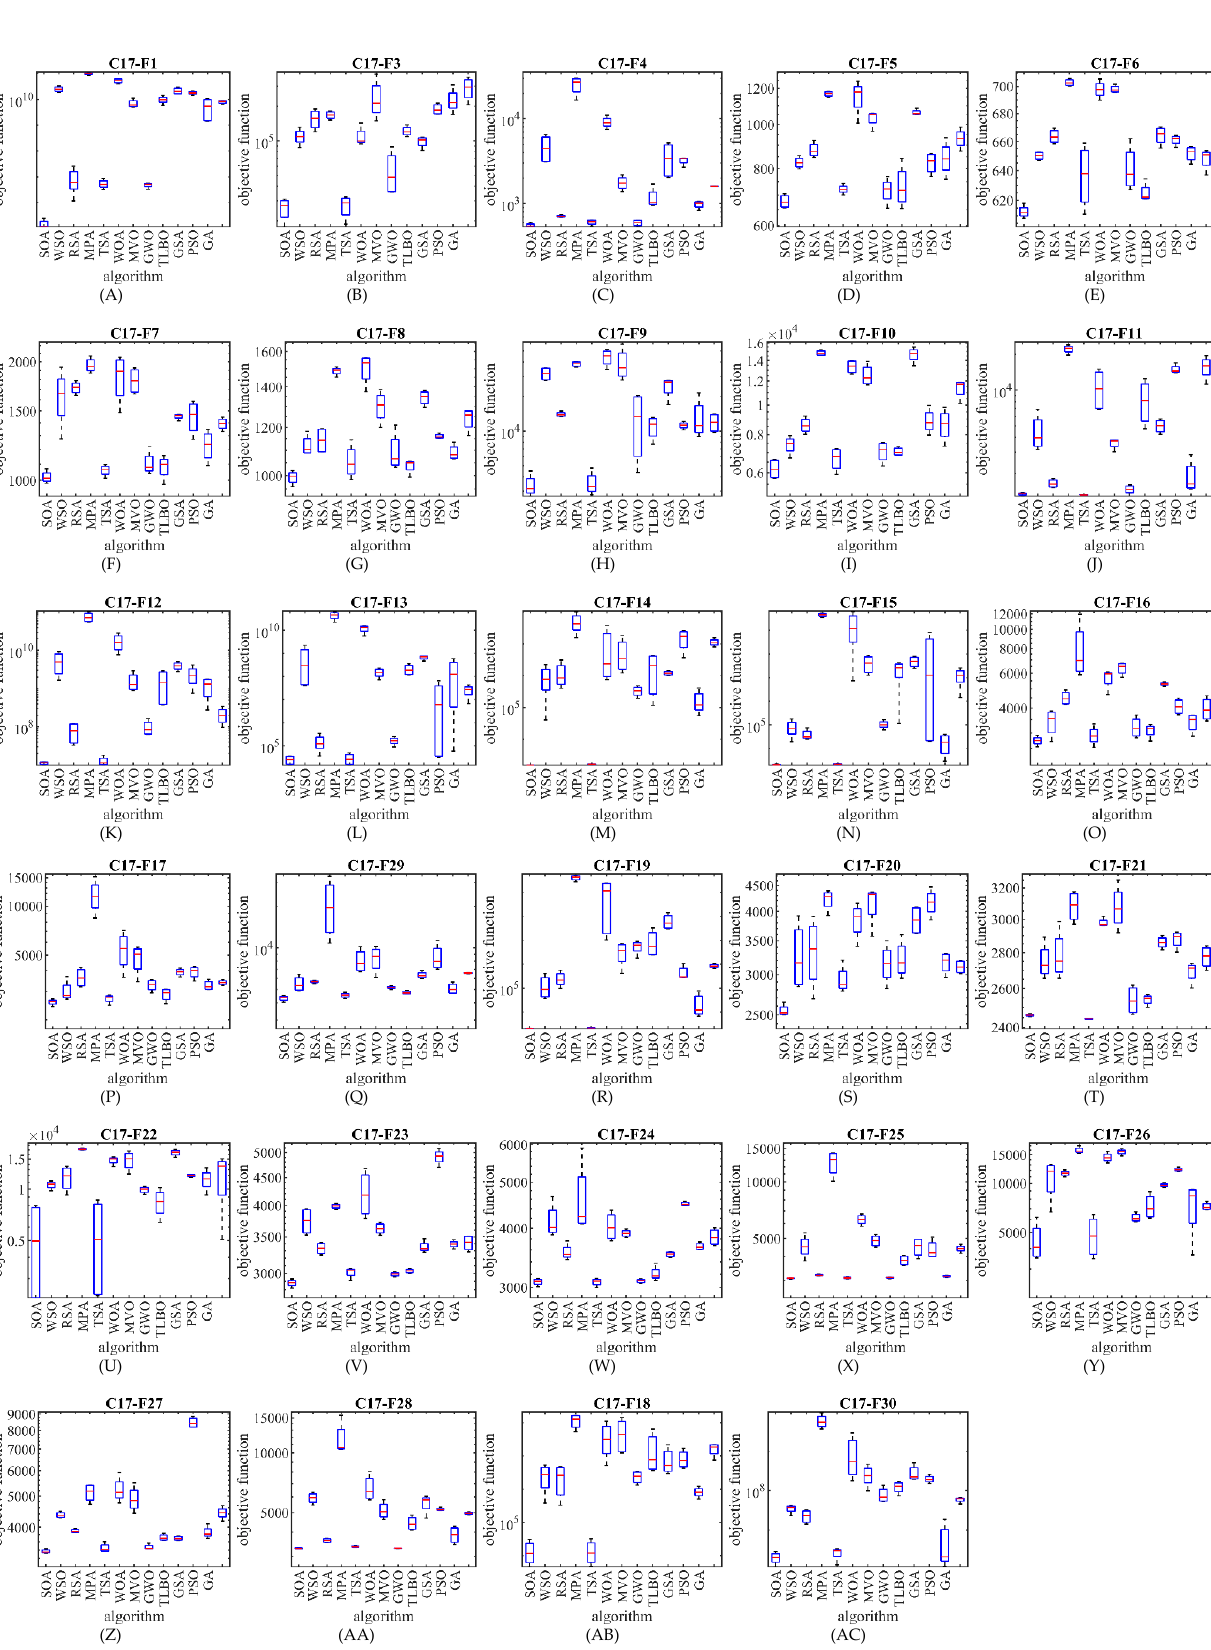
Figure 3. Boxplot diagram of SOA and competitor algorithms performances on the CEC 2017 test suite (for the dimension 𝑑 = 30 ).